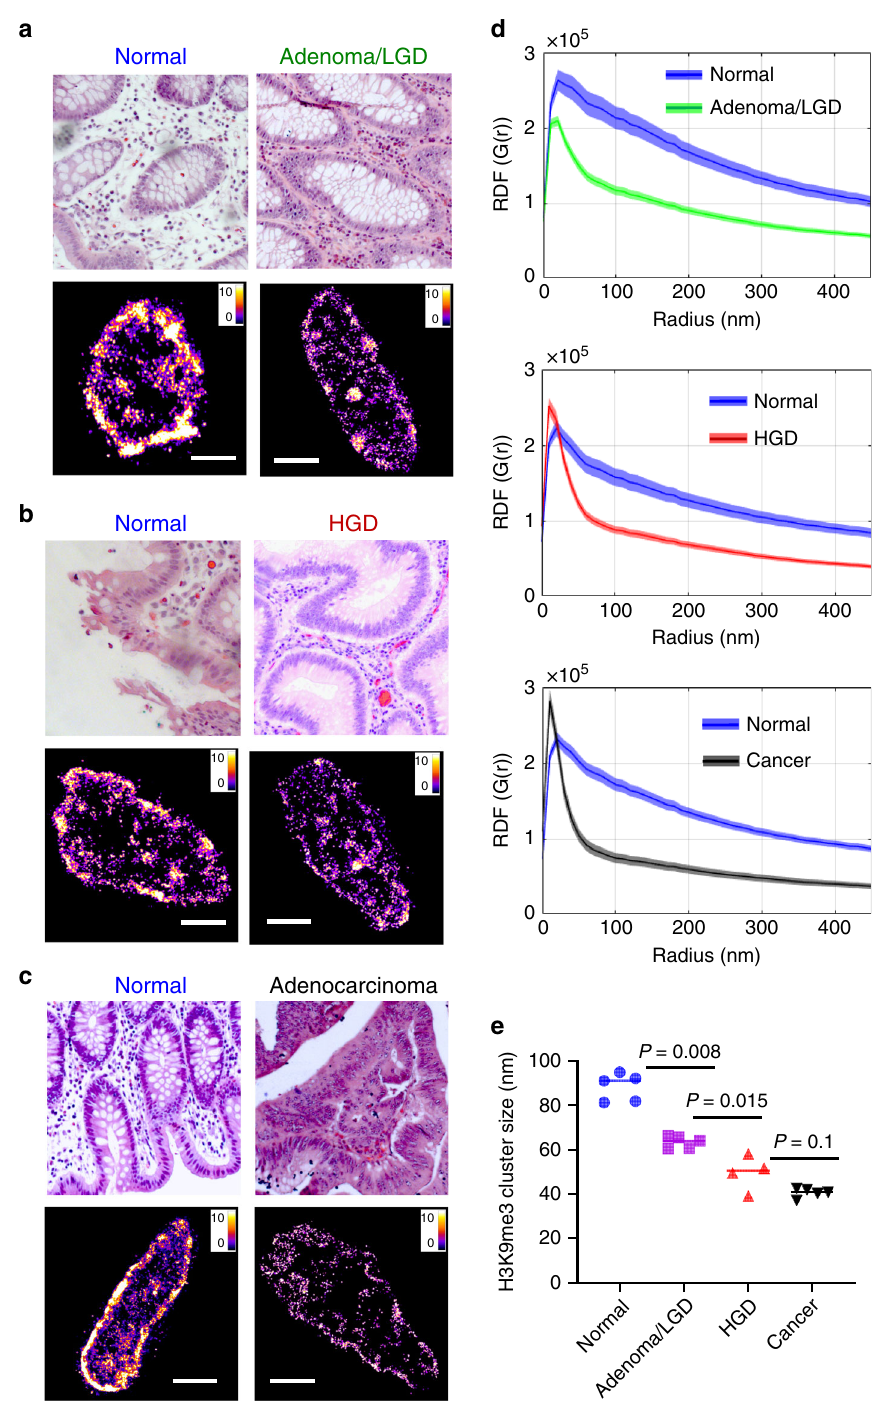
Fig. 6 Super-resolution imaging of disrupted heterochromatin structure in human neoplasia. a – c Representative histology and corresponding super- resolution images of heterochromatin structure for colorectal neoplastic lesions together with their paired normal tissue located at more than 10 cm away from the tumor. Scale bars: 2 µ m. d The radial distribution functions (RDF) for characterization of H3K9me3-dependent heterochromatin structure for the normal-tumor pairs. All P values between two groups are P < 10 − 20 . e The average H3K9me3 cluster size for a total of 19 patient samples (patient information shown in Supplementary Table 1) including fi ve normal tissue from non-neoplastic patients, fi ve adenoma or low-grade dysplasia (LGD), four high-grade dysplasia and fi ve invasive colorectal cancer. Each point is the average of over 100 cell nuclei for each patient. All P values were determined using Mann − Whitney protease inhibitors). CUT&RUN was performed as previously described 30 . Brie fl y, lectin-coated Concanavalin A beads (Polysciences) were prepared using binding